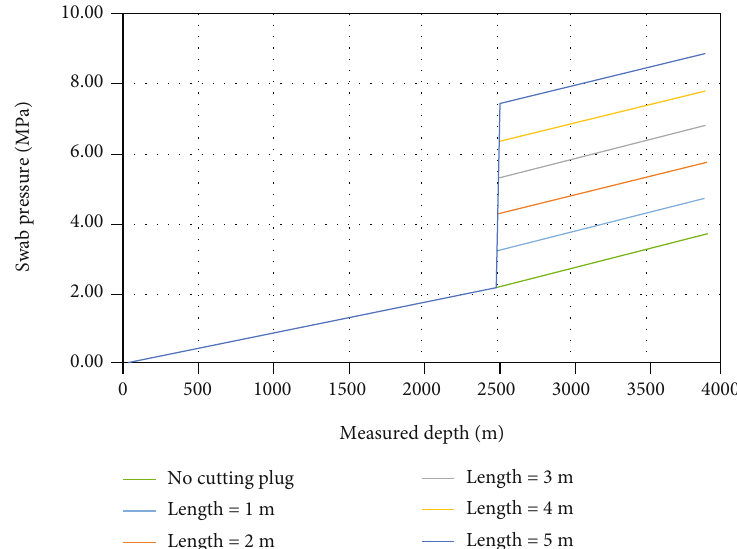
Figure 6: The e ff ect of cutting plug length on the swab pressures in a closed pipe